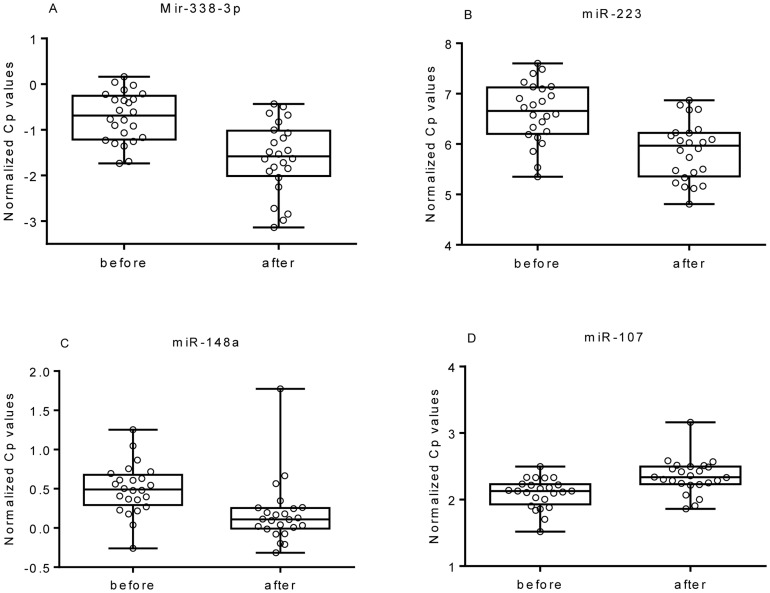
Box plots.Box plots showing the expression levels of (A) miR-338-3p, (B) miR-223, (C) miR-148a and (D) miR-107 before (n = 24) and after (n = 24) resection of early-stage breast cancer. Each circle represents a sample value.